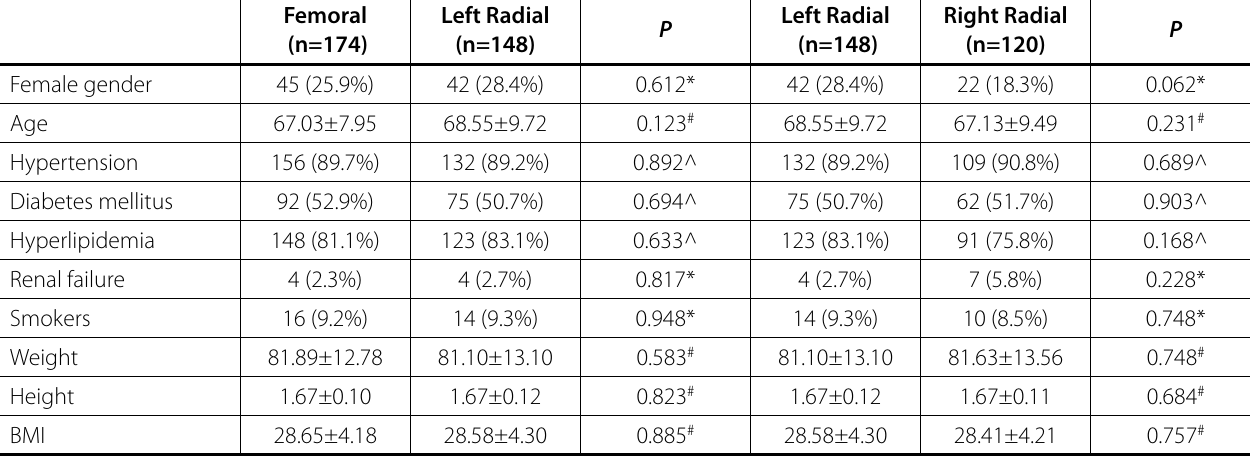
Table 1 . Baseline characteristics of patients. Femoral vs . left radial and right radial vs . left radial group.